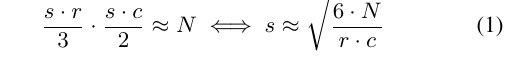
Figure 3. Example for problems in window detection on low resolution images. From top to bottom: original resolution ( 2590 × 1715 pixel), 1 / 16 of the original resolution and 1 / 32 of the original resolution.